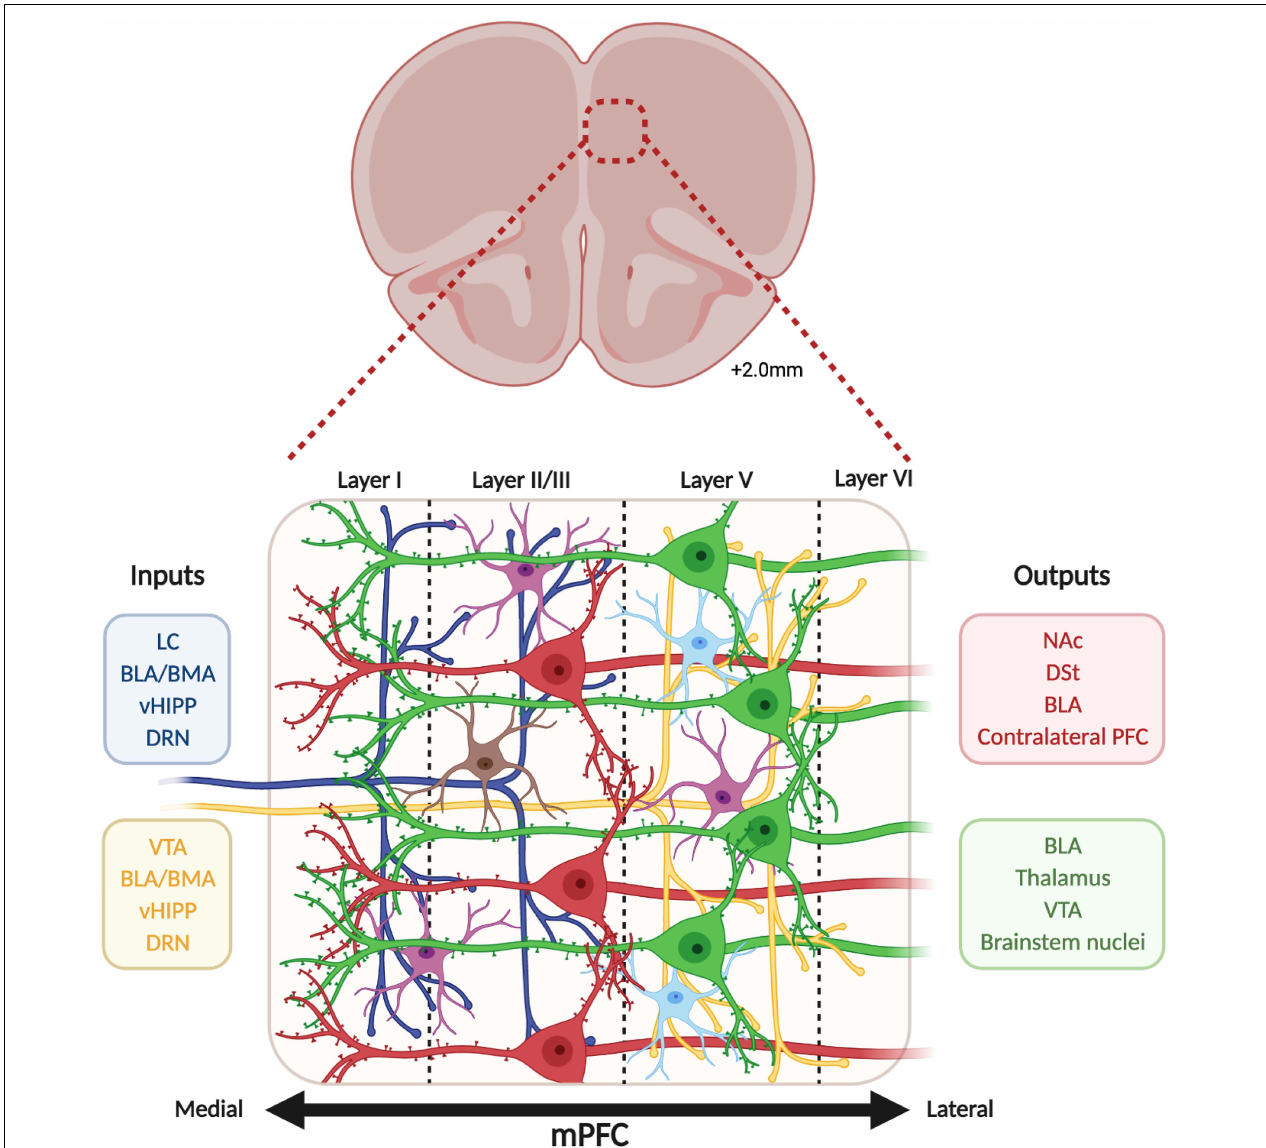
FIGURE 2 | Cellular organization of the medial prefrontal cortex. The medial prefrontal cortex is organized in layers, numbered I (medial, close to the midline) to VI (lateral). Pyramidal glutamate neurons are lying in layers II/III (red), V (green), and VI (not represented), while GABAergic interneurons (somatostatin in purple, parvalbumin in blue, and vasoactive intestinal peptide in brown) are spread in layers I, II/III and V. The mPFC receives layer-specific inputs (dark blue and yellow) from locus coeruleus (LC), basolateral and basomedial amygdala (BLA and BMA), ventral hippocampus (vHIPP), dorsal raphe (DRN) and ventral tegmental area (VTA) while mPFC pyramidal neurons send projections (red and green) to the nucleus accumbens (NAc), dorsal striatum (DSt), BLA, contralateral PFC, thalamus, VTA and brainstem